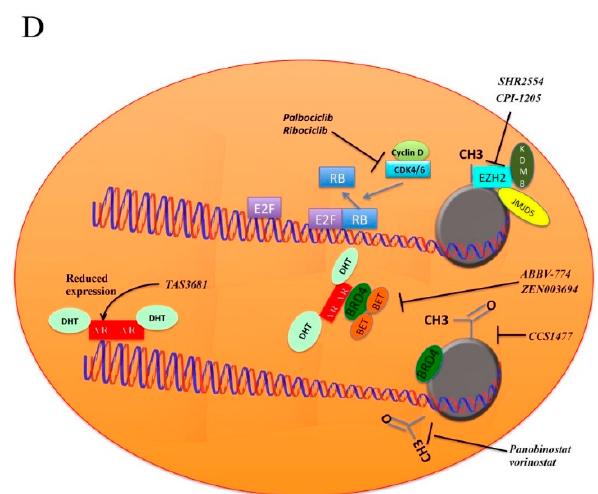
Figure 2. Androgenesis inhibition. ( A ) Adrenal androgen steroidogenesis. CYP17A1: cytochrome P450 family 17 subfamily A polypeptide 1 with two activities: 17 α -hydroxylation (green) and 17, 20-lyase (orange); both activities are inhibited by abiraterone. CYP11A1: cytochrome P450 family 11 subfamily A polypeptide 1. 3 β -HSD: 3 β -hydroxysteroid dehydrogenase. 17 β -HSD: 17 β -hydroxysteroid dehydrogenase. SULT2A1: bile salt sulfotransferase. STS: steryl-sulfatase. DHEA: